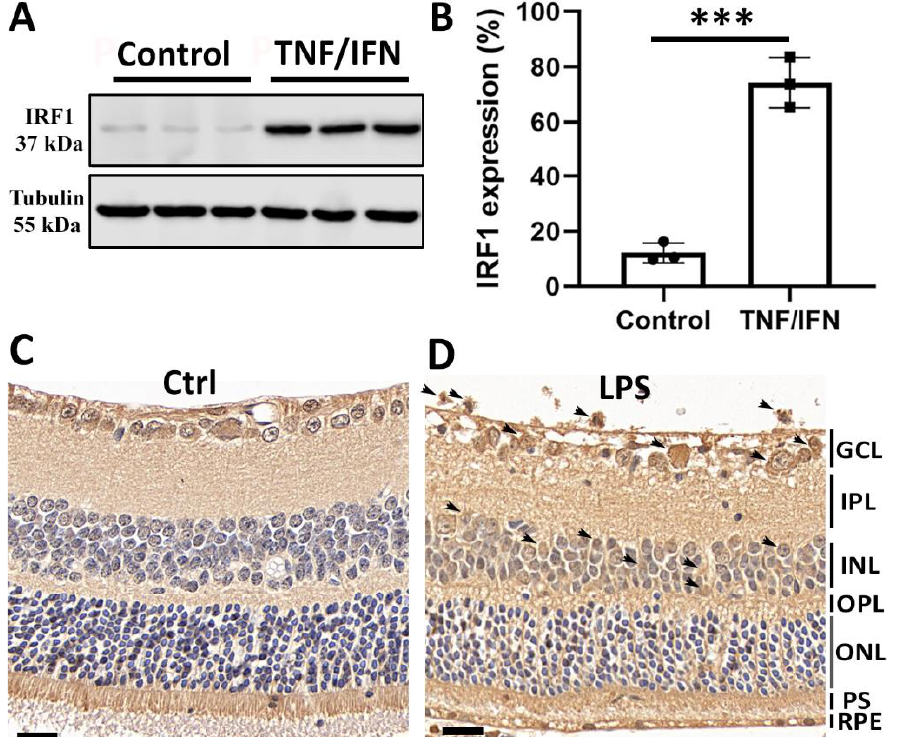
Figure 1. Increased IRF1 protein expression level in activated retinal microglia. ( A , B ) IRF1 protein upregulation in primary retinal microglia by 20 ng/mL tumor necrosis factor- alpha (TNFα) and 20 ng/mL interferon- gamma (IFNγ) for 2 4 h. The Western blot images of IRF1 (( A ), Tubulin as loading control) and densitometric quantification results by ImageJ software (( B ), % of Tubulin) are shown. Primary retinal microglia were derived from mice (~p10). The replicate numbers = 3. *** p < 0.001. ( C , D ) The increased IRF1 protein level in the mouse retina by lipopolysaccharide (LPS,100 ng/µL) for 24h. The representative IHC-DAB staining images (n = 3) for the PBS control ( C ) and LPS ( D ) treatments ae shown. Arrows indicate the IRF1 staining signals).. Scale bar: 20 µm.